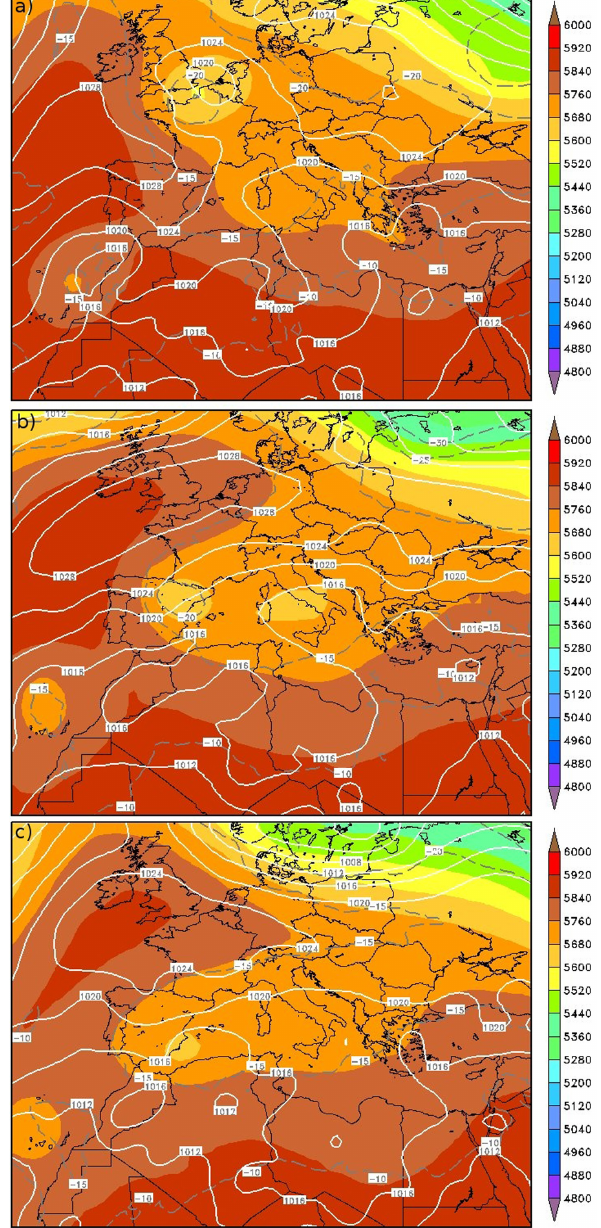
Fig. 3. Sea level pressure (hPa, solid line), geopotential height (gpm, shaded color) and temperature in ◦ C (dashed line) at 500hPa on (a) 10 October 2007 at 00:00UTC, (b) 11 October 2007 at 00:00UTC and (c) 12 October 2007 at 00:00UTC, obtained from NCEP Reanalysis